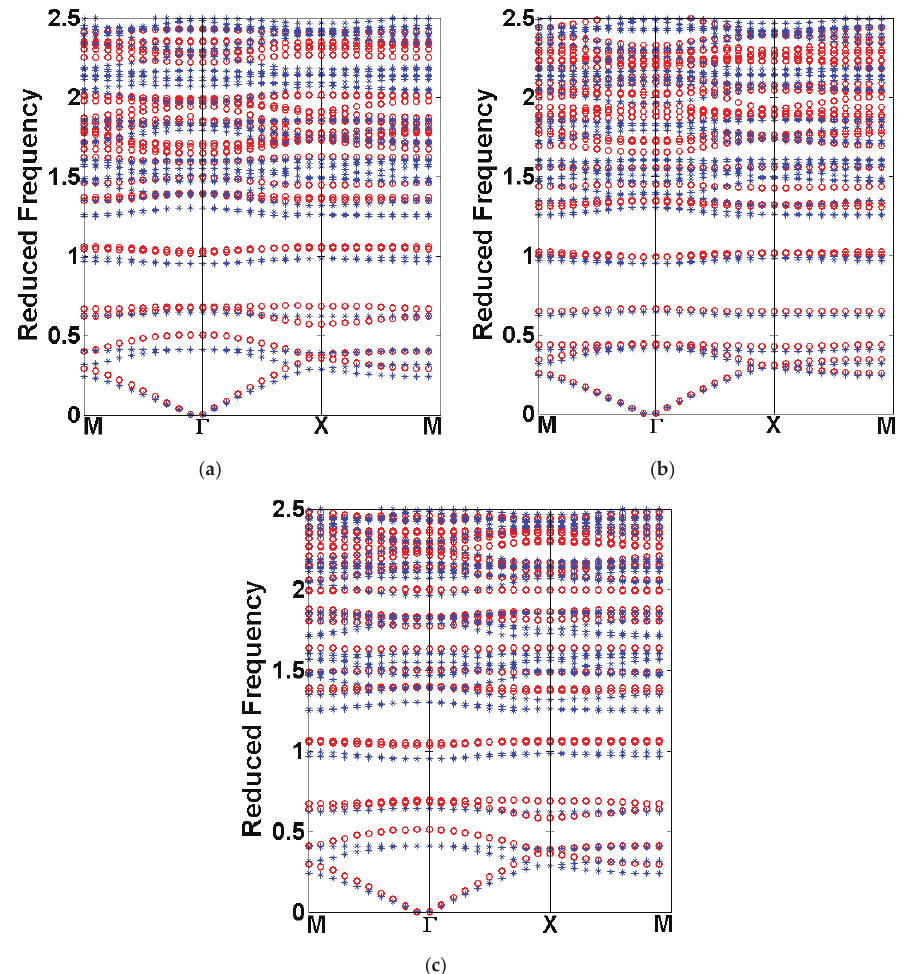
Figure 3. Dispersion diagram comparison of the MPnC with circular scatterers and Kagomé lattice for f = 0.5, considering Z modes without piezoelectricity and piezomagnetism (blue asterisks in ( a – c )), Z modes with piezoelectricity (red circles in ( a )), Z modes with piezomagnetism (red circles in ( b )), and Z modes with piezoelectricity and piezomagnetism (red circles in ( c )). The Z modes with piezo effects (red circles in (a–c)) were shifted to higher frequencies in